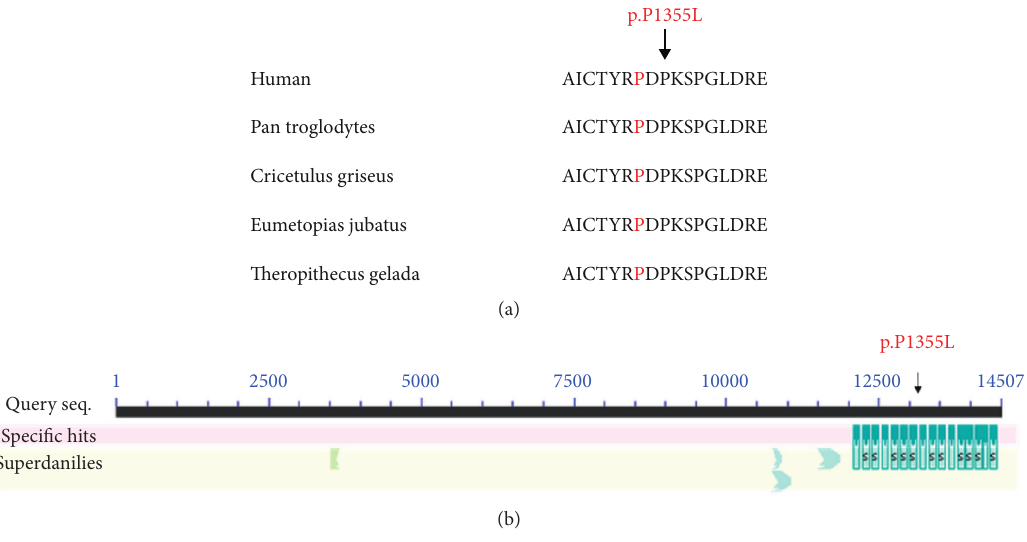
Figure 6: (a) Affected amino acid residue of MUC16 highly conserved between different species. (b) Conserved domains in fatty acid synthase.